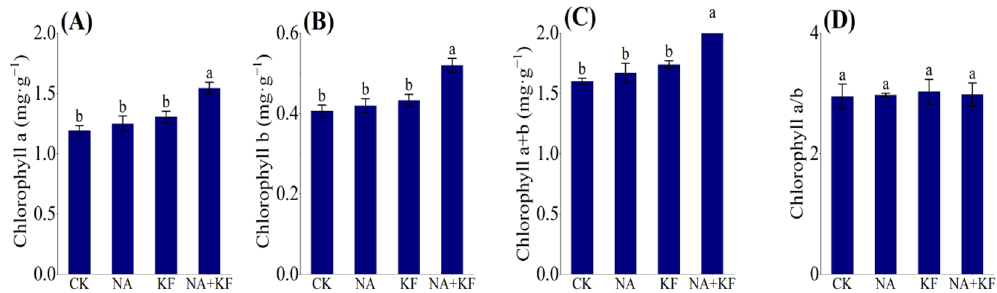
Figure 3. Effects of different treatments on leaf chlorophyll content of tomato seedlings. ( A ) Chlorophyll a , ( B ) Chlorophyll b , ( C ) Chlorophyll a + b , ( D ) Chlorophyll a/b , NA, 5 mg·kg −1 NA; KF, 60 mg·kg −1 KF; NA + KF, 5 mg·kg −1 NA and 60 mg·kg −1 KF. Different lowercase letters denote statistical differences among treatments of tomato seedlings at the 5% level according to LSD test. Error bars above mean indicate standard error (n =